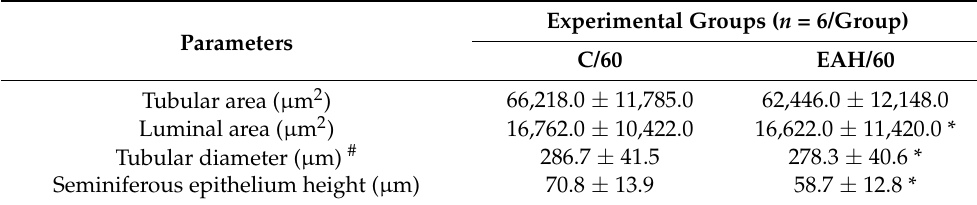
Table 4. Effect of treatment with EAH on the testicular morphometric